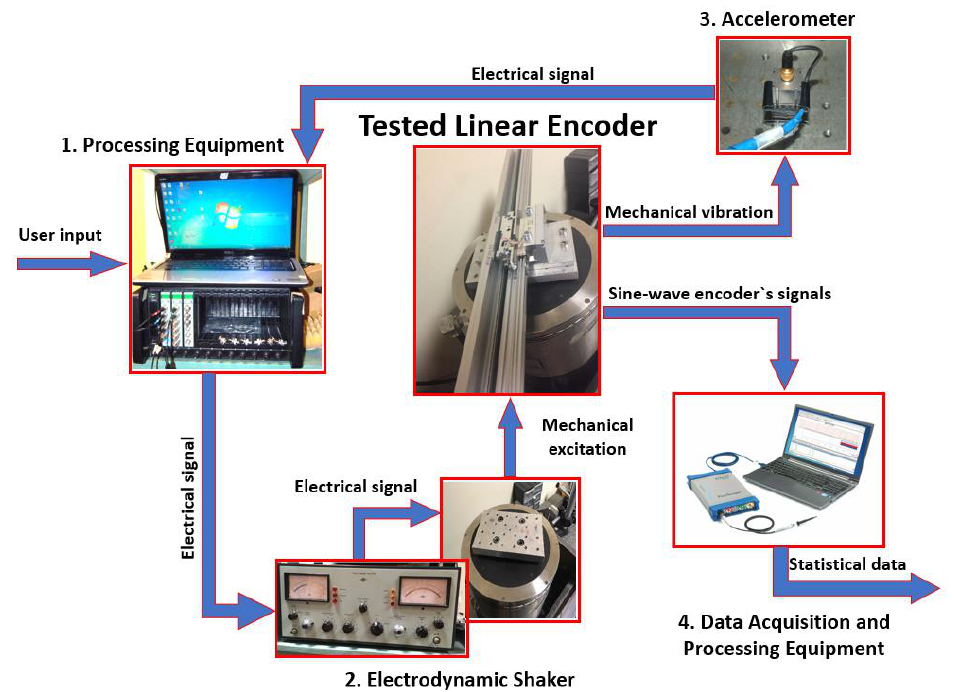
Figure 6. Schematic representation of the experimental setup for the encoder’ s dynamic behavior investigation. investigation.